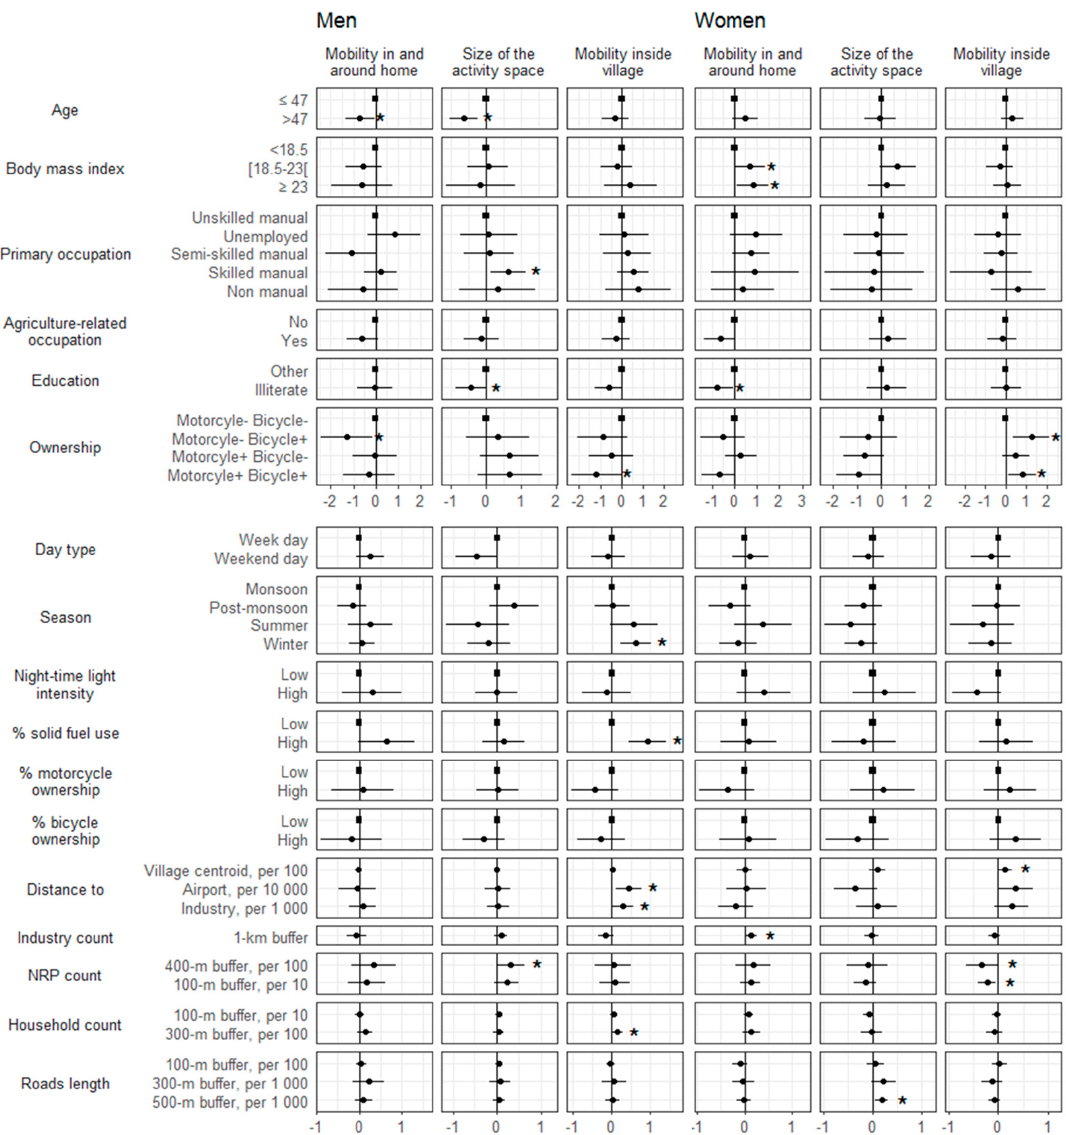
Figure 2. Effects of individual, external, village-level and Geographic Information System (GIS)-derived predictors on the three main dimensions of mobility in men and women. Figures are effect estimates (points) and 95% confidence interval (bars) derived from mixed model with random intercept per participant. Each predictor was investigated individually. Adjustment for age did not change the results. Squares indicate reference categories. Stars indicate statistical significance at the 5% level. Distance, industry count, non-residential place count, household count, and road length are considered as continuous variables. For clarity purposes, only the three dimensions common to men and women are presented. We scaled the dimensions scores so that higher values of the estimates indicated more mobility in the corresponding dimension. Body mass index is expressed in kg/m 2 , distances are expressed in meters. Night-time light intensity was used as marker of village urbanicity. Low and high categories in village-level factors were derived from population median value. Abbreviations: NRP: non-residential place.